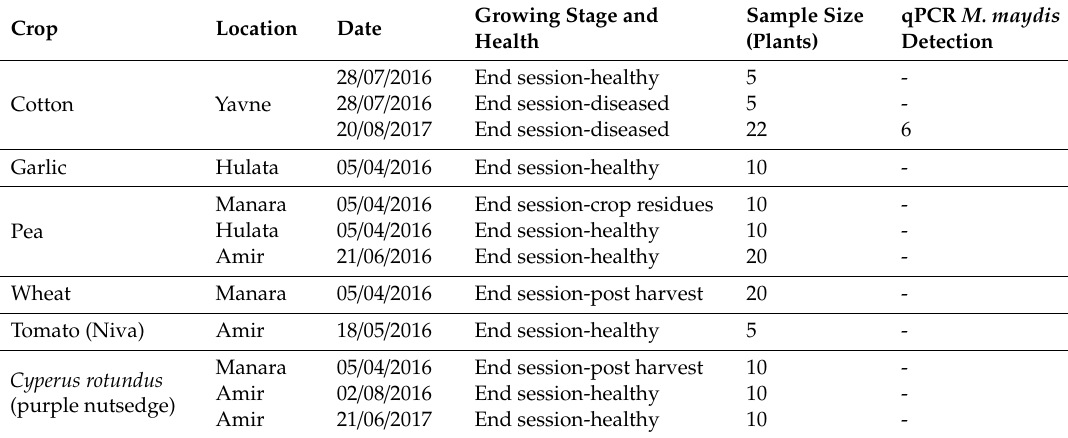
Table 1. Random sampling from Magnaporthiopsis maydis -contaminated agricultural fields scattered throughout the Hula Valley in the Upper Galilee (northern Israel) or in Yavne, in the southern coastal plain of Israel 1